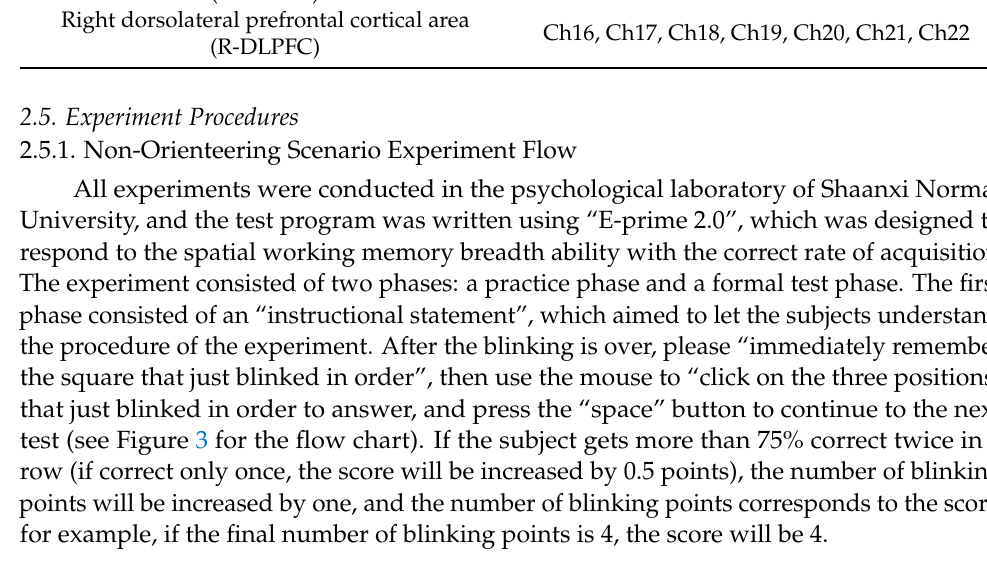
Table 2. Correspondence table between channel layout and brain regions of portable fNIRS devices. Brain Regions Corresponding Channels Left ventral lateral prefrontal cortical area Ch1, Ch2, Ch3, Ch4, Ch5, Ch7 (L-VLPFC) Left dorsolateral prefrontal cortical area Ch6, Ch8, Ch9, Ch10, Ch11, Ch12, Ch13 (L-DLPFC) Right ventral lateral prefrontal cortical area Ch23, Ch24, Ch25, Ch26, Ch27, Ch28 (R-VLPFC) Right dorsolateral prefrontal cortical area Ch16, Ch17, Ch18, Ch19, Ch20, Ch21, Ch22 (R-DLPFC)